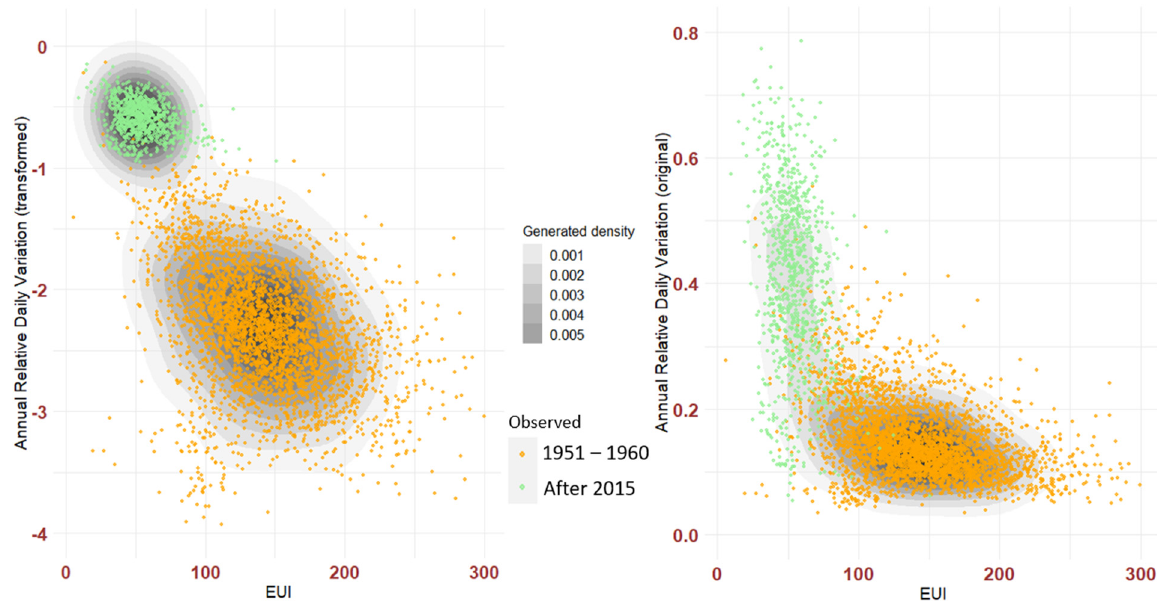
Figure 8. Density comparisons for the bivariate generative model.